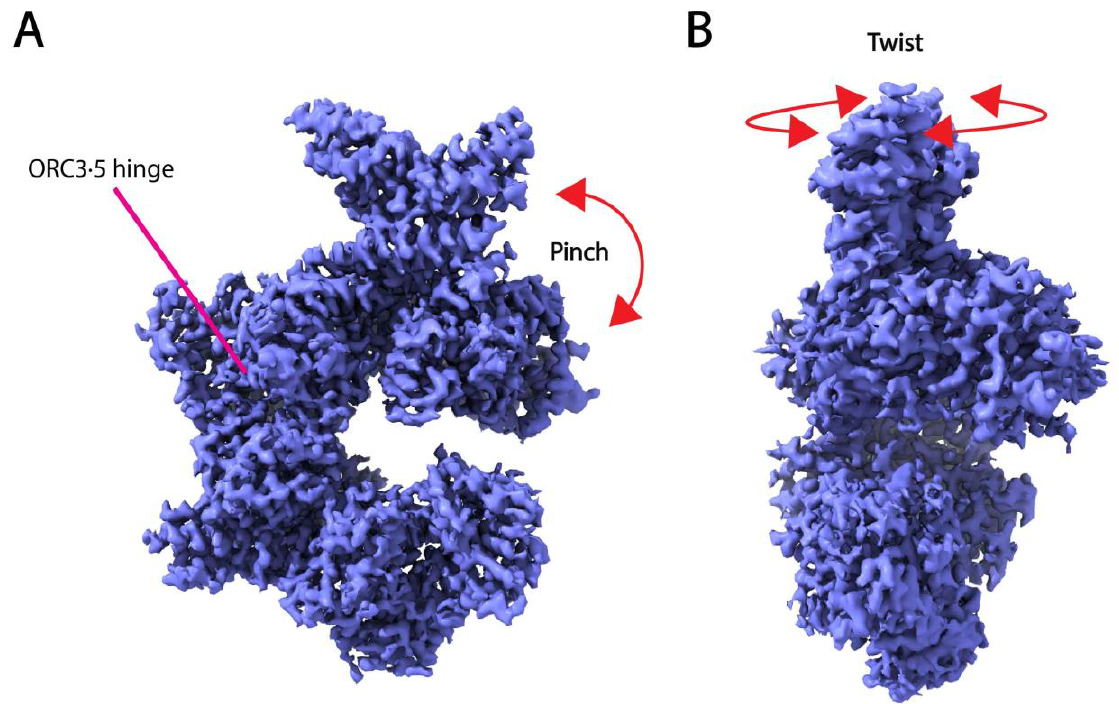
Figure 6. Twisting ( A ) and pinching ( B ) movements of the open human recognition complex (ORC) were revealed by PCA employed by multi-body refinement in RELION and 3DVA in cryoSPARC [166]. Both motions emanate from a hinge at the interface of the ORC3 and ORC5 subunits. The cryo-EM map shown in the figure is the map of the open ORC, (EMD-22417).